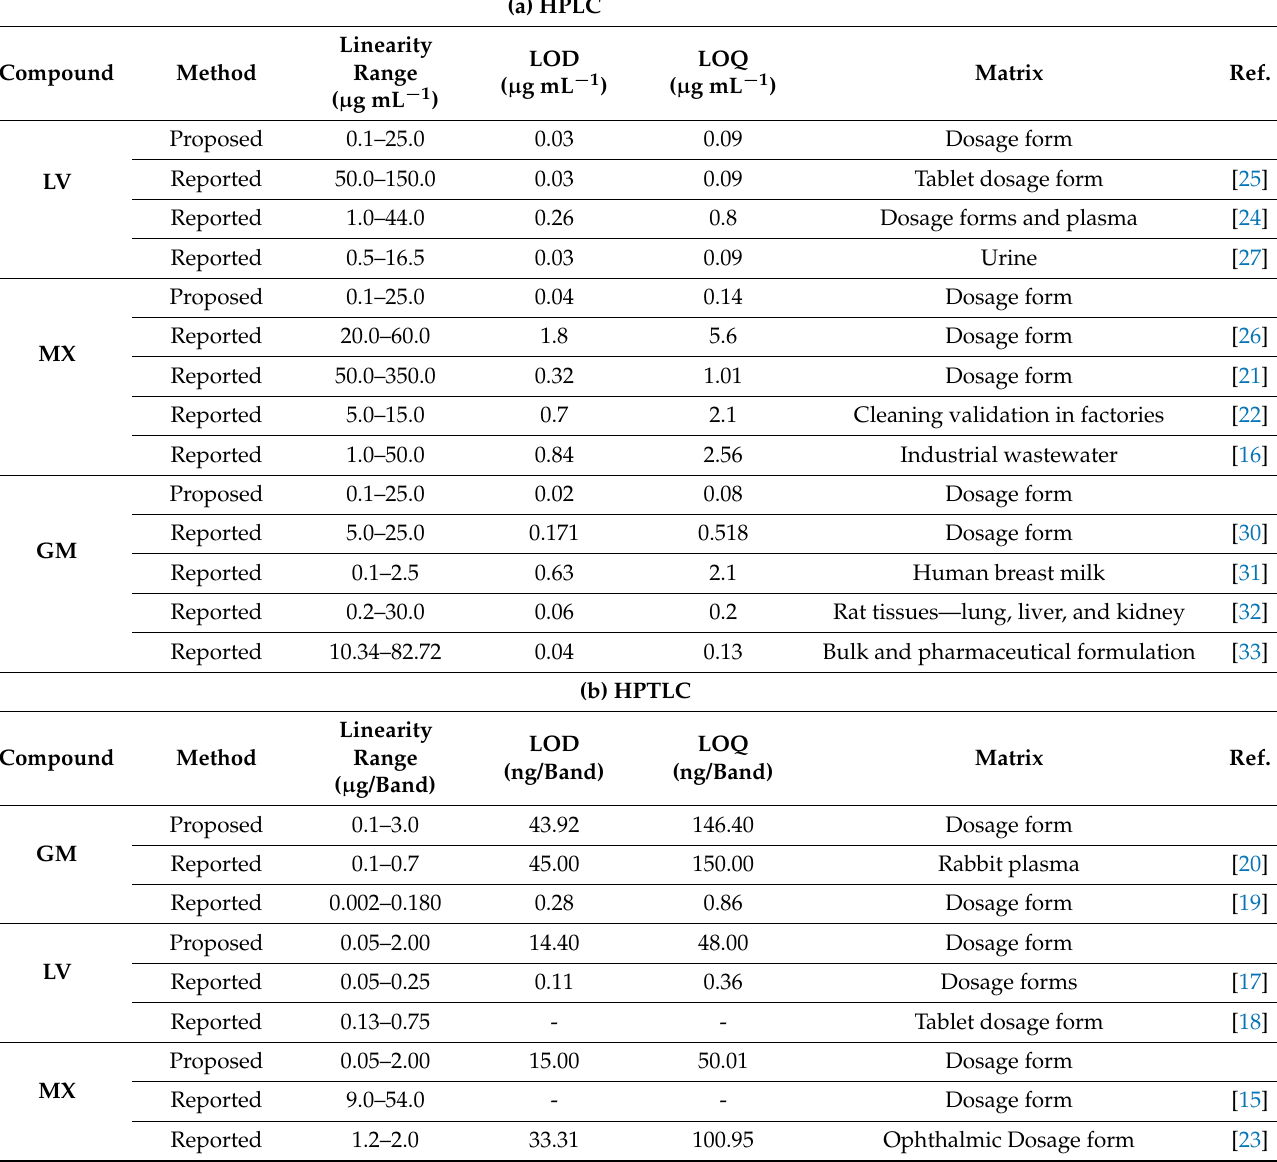
Table 4. A comparison of figures of merit between (a) the proposed green HPLC and the previously reported HPLC methods and (b) the proposed green HPTLC and the previously reported HPTLC